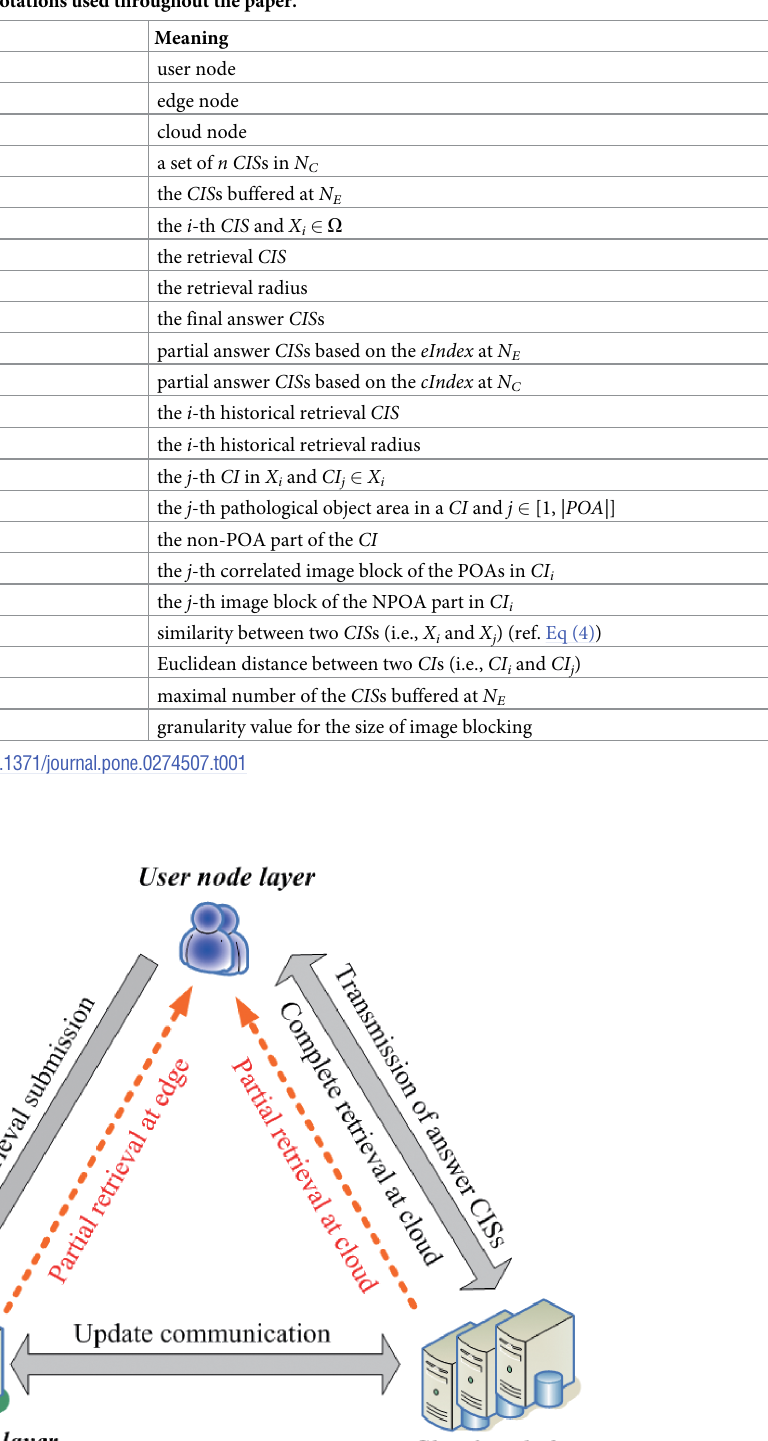
Table 1. Main notations used throughout the paper.